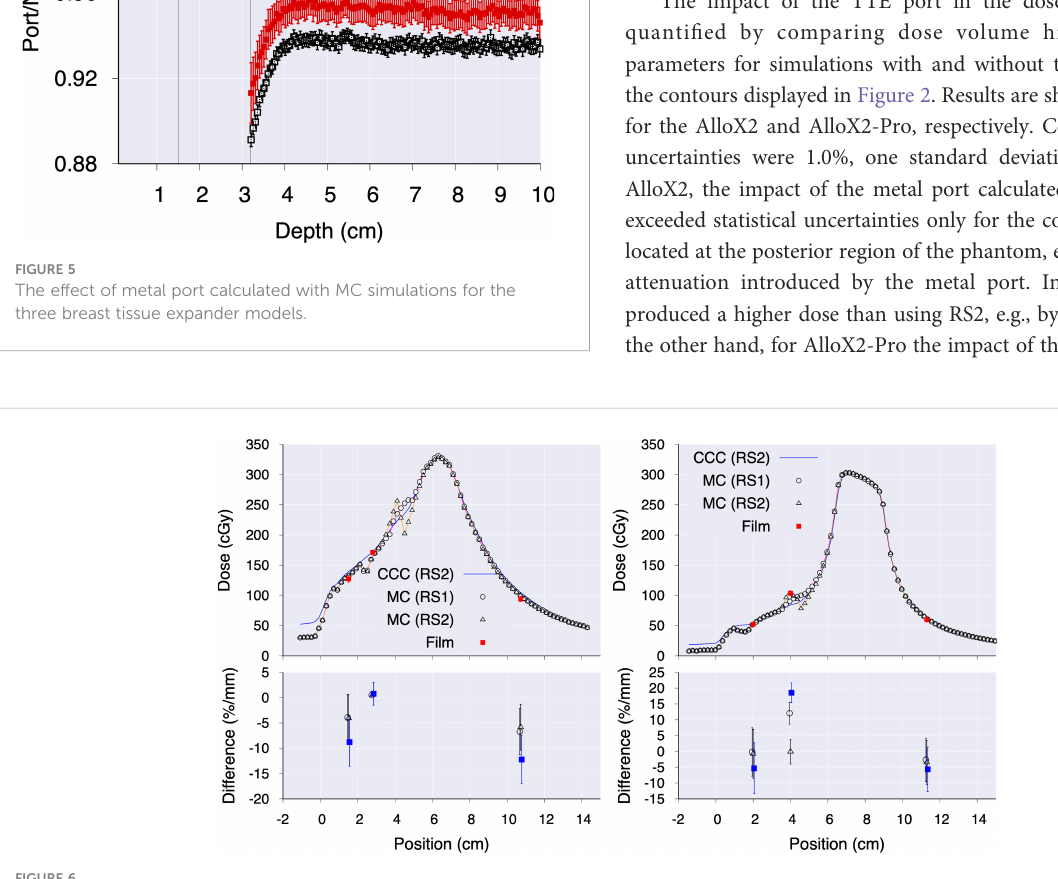
FIGURE 6 Dose pro fi les along the anterior-posterior direction for AlloX2 (left) and AlloX2-Pro (right). For CCC, only results using RS2 are shown. The panels at the bottom show the difference between measured and calculated